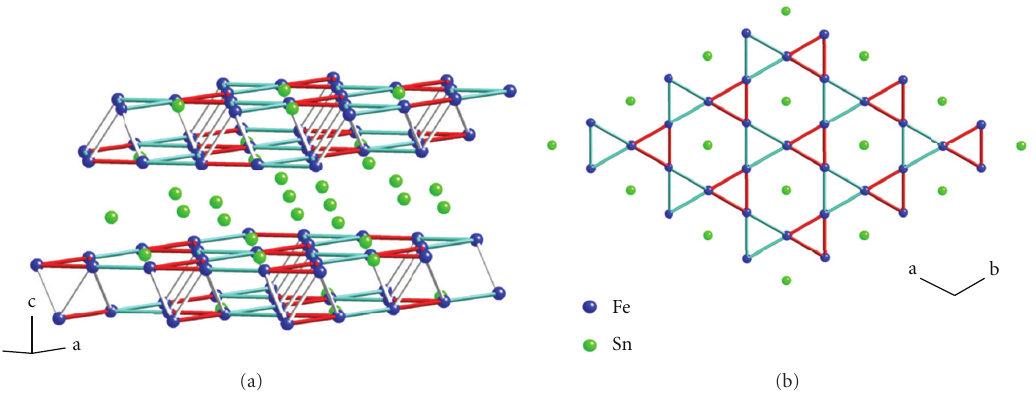
Figure 9: (a) Crystal structure of Fe 3 Sn 2 showing the kagome bilayers separated by layers of Sn atoms. (b) View perpendicular to the ab - plane showing an Fe kagome layer: the red and blue Fe–Fe bonds denote two di ff erent sizes of equilateral triangles. The Sn atoms within the bilayers occupy positions at the centre of the kagome hexagons to form a triangular network. The figure is taken from [13].